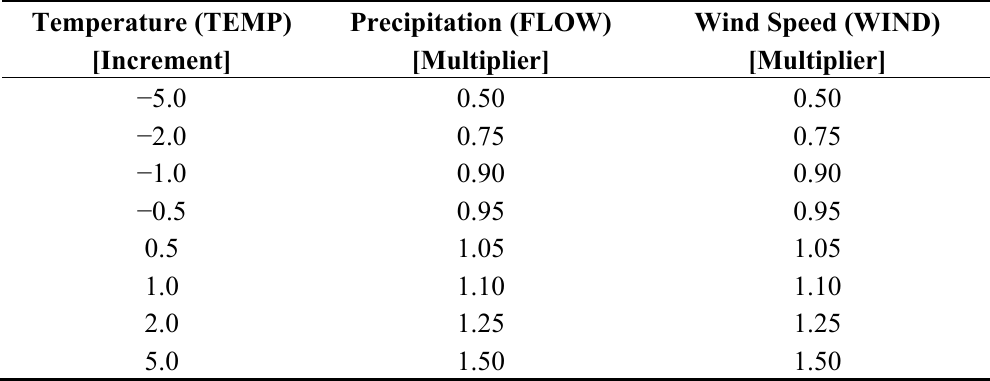
Table 2. Boundary condition modifications applied in the sensitivity analysis. A scenario was generated for each change in meteorological variable, resulting in 24 scenarios differing from the base